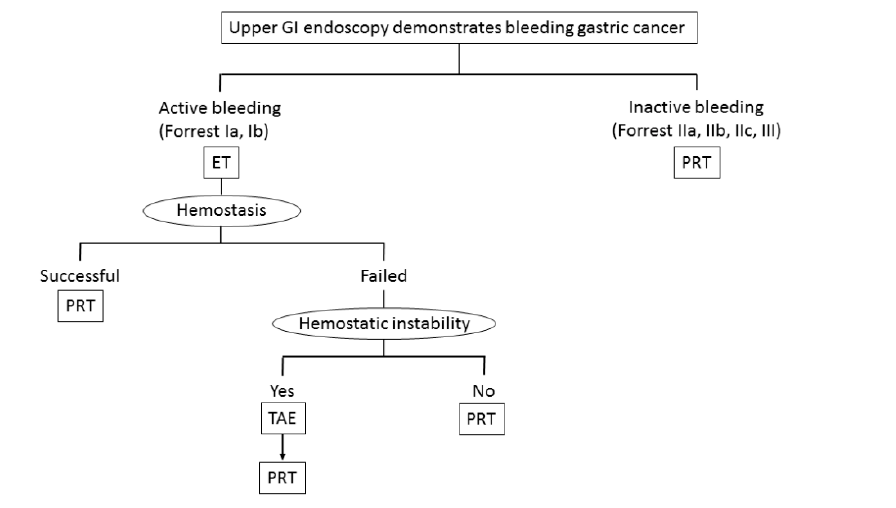
Figure 7. Treatment strategy for bleeding from unresectable gastric cancer.